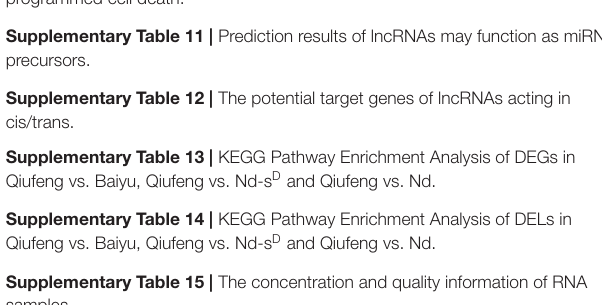
Supplementary Table 6 | Differential expression of mRNAs in Qiufeng vs. Nd-s D .